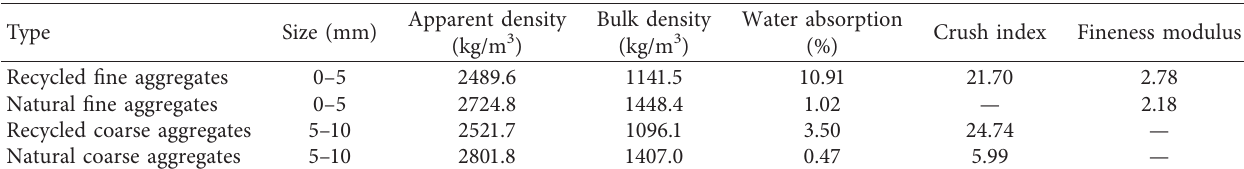
Figure 1: Composition of recycled concrete aggregates. (a) Recycled fine aggregates (0–5mm); (b) recycled coarse aggregates (5–10 mm). Table 2: Physical properties of aggregates.